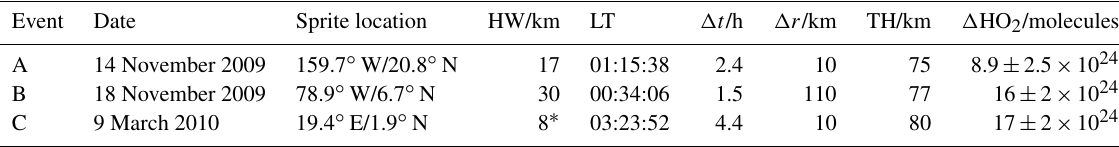
Table 1. The three events analysed in Yamada et al. (2020). HW is the horizontal width of the sprites emissions, LT is the local time of the SMILES measurement, (cid:49)t is the time difference between the sprite observation and the SMILES measurement, (cid:49)r is the shortest distances between the field of view of the SMILES measurement and the sprite location, TH is the tangent height of the SMILES measurement, and (cid:49) HO 2 is the total enhancement along the line of sight of the SMILES